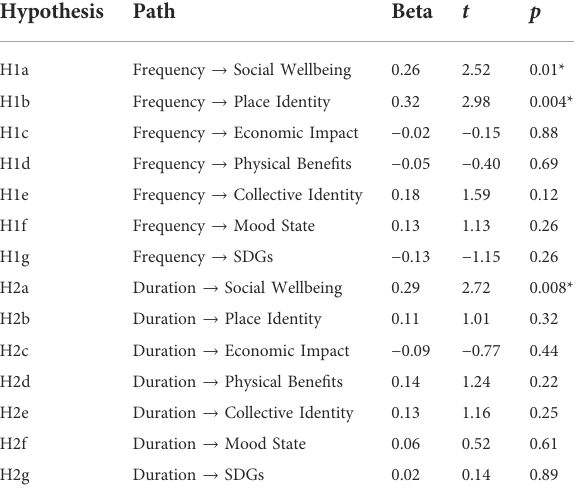
TABLE 4 Summary of regression results per hypothesis.